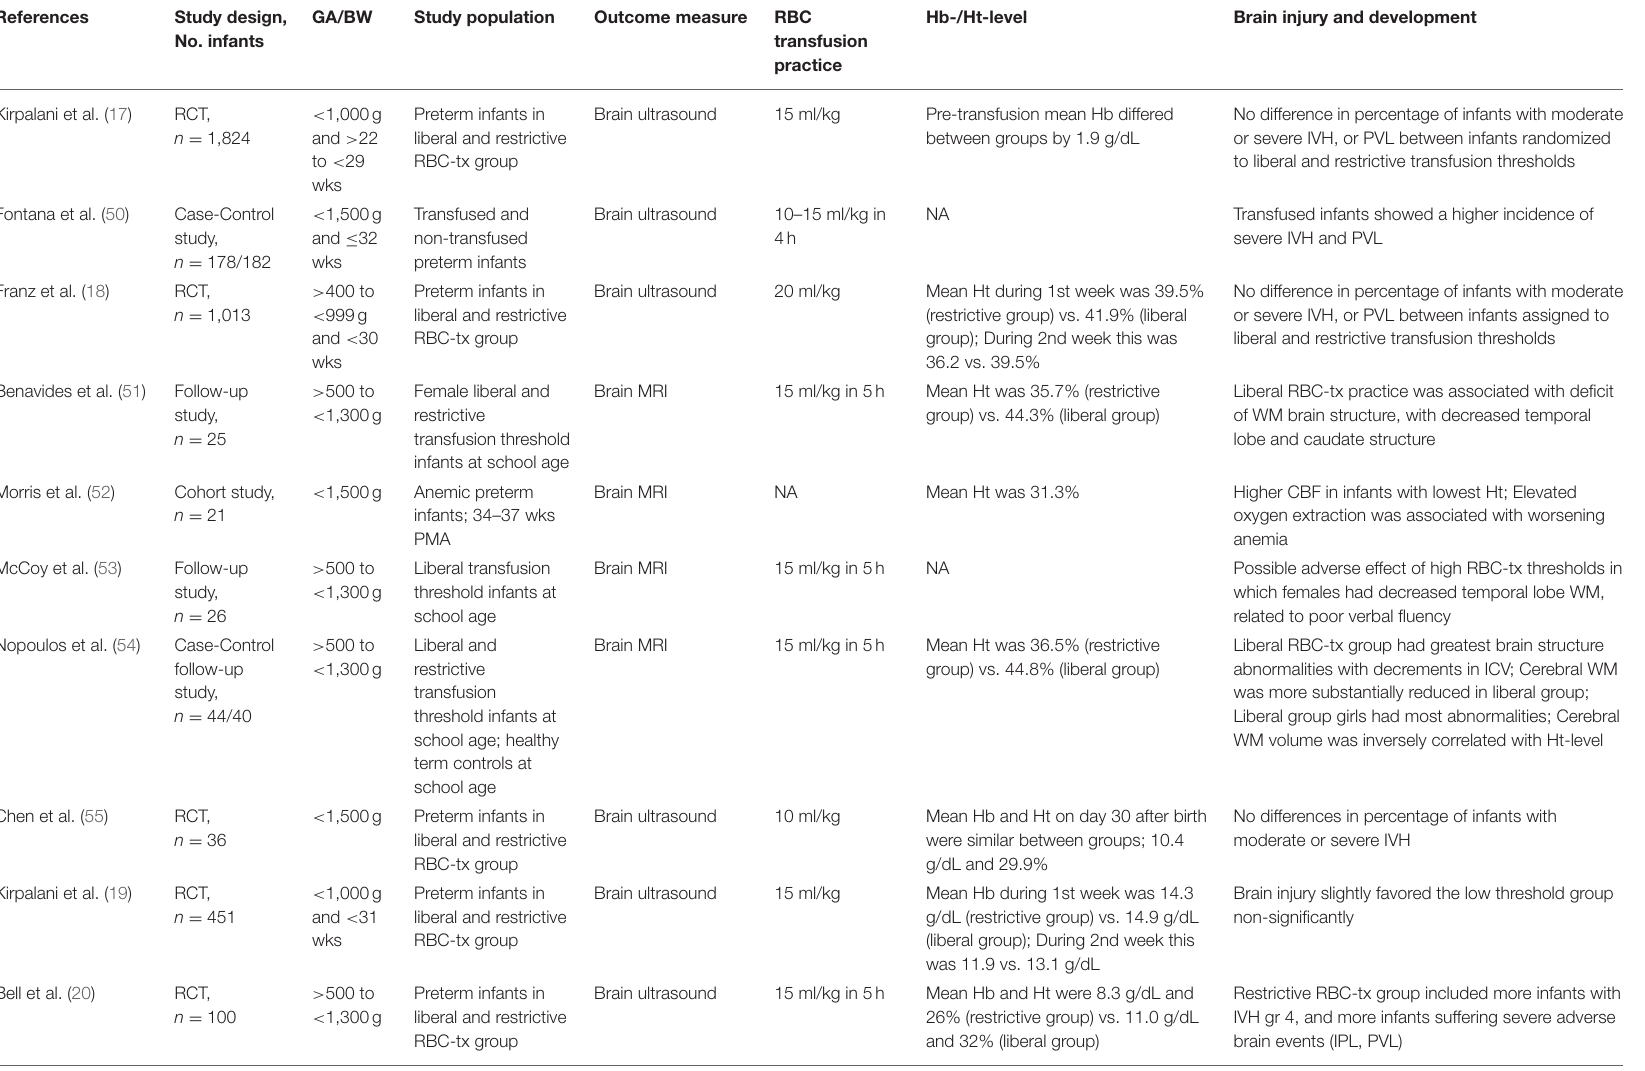
TABLE 2 | Results of selected studies on brain injury and